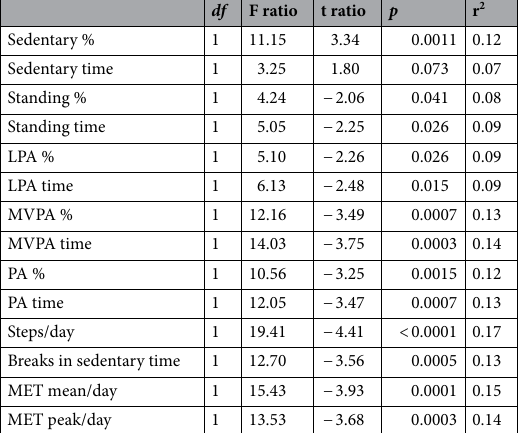
Table 3. Associations between fasting insulin (log10) and accelerometer measures, least squares effect tests with sex and age included in the model. LPA light physical activity, MVPA moderate to vigorous physical activity, PA physical activity (LPA and MVPA together), MET the metabolic equivalent.